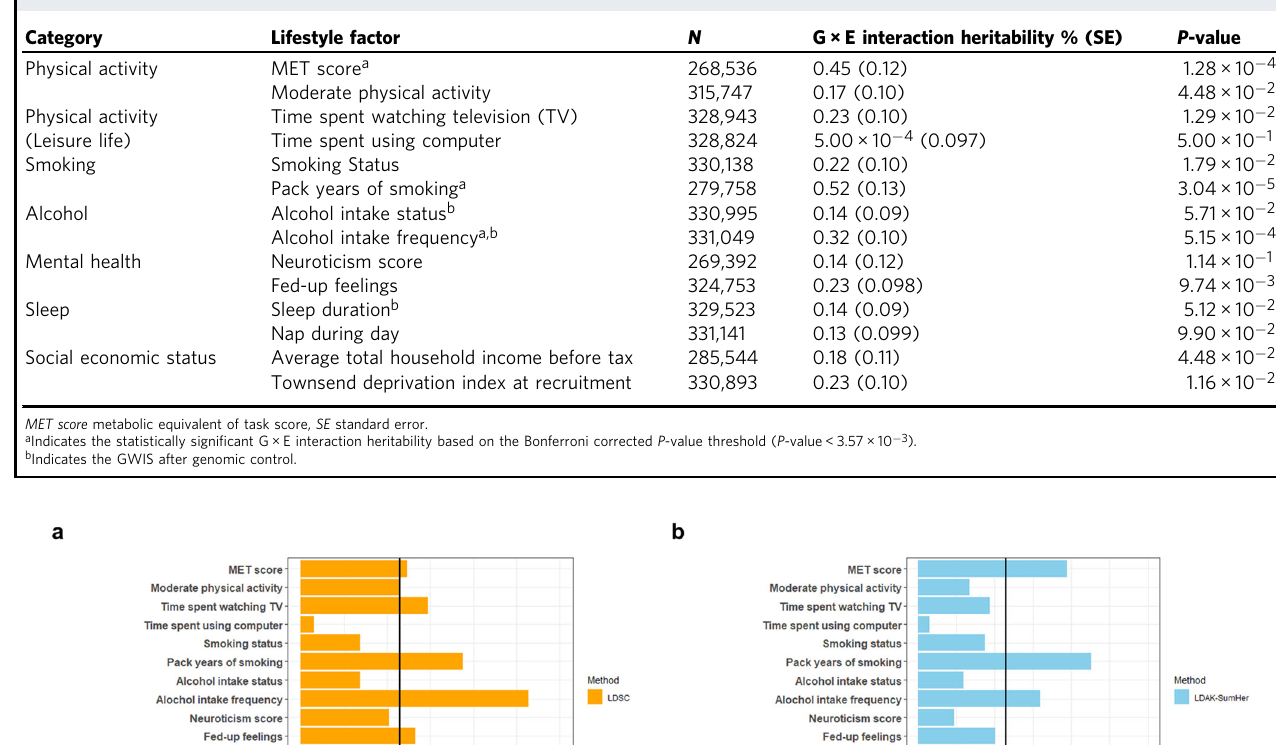
Table 3 G × E interaction heritability calculated using the LDAK-SumHer method.